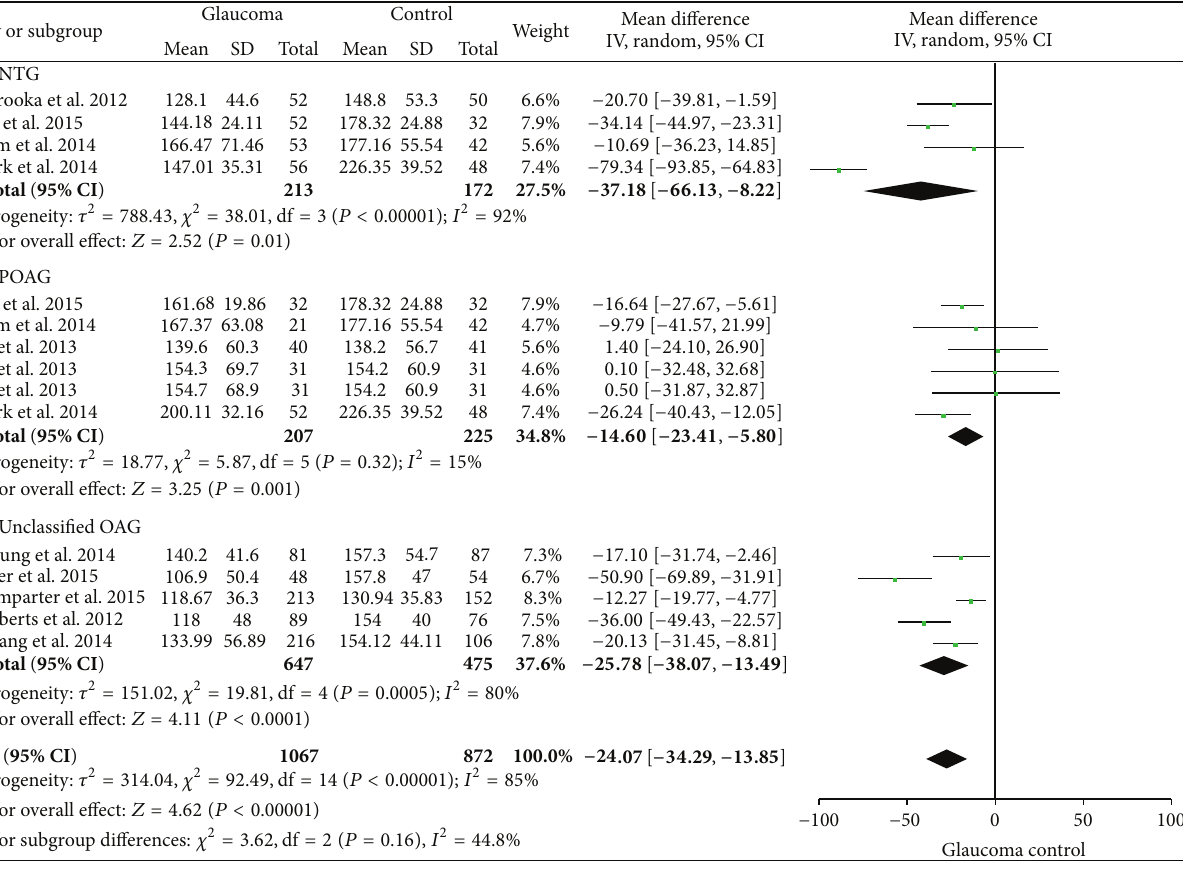
Figure 4: Forest plot of subgroup analysis of average PPCT.